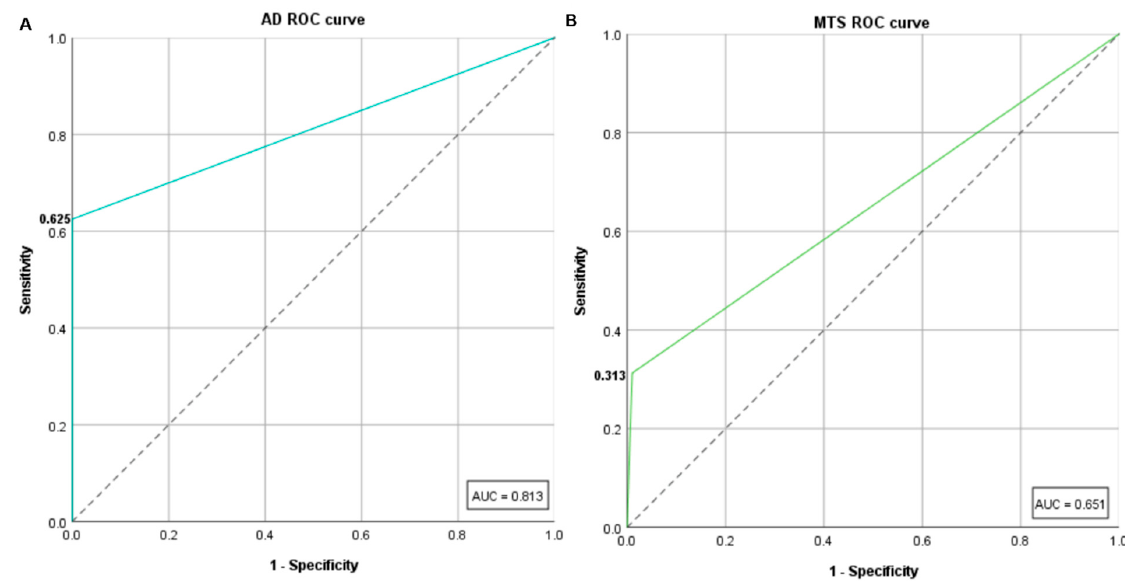
Figure 3. Receiver operating characteristic (ROC) curves of AD ( A ) and MTS ( B ) and their respective areas under the ROC curves (AUC), 0.8 and 0.7.